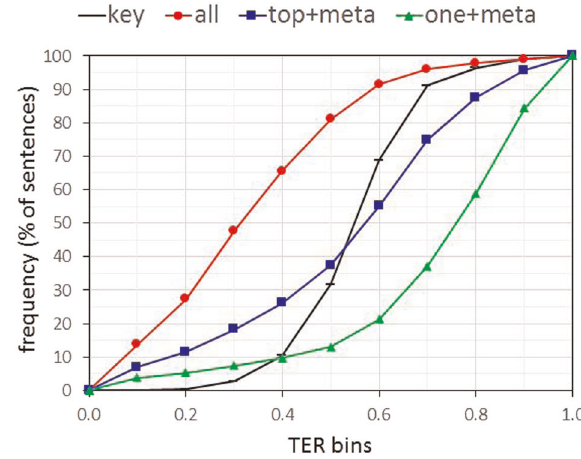
Fig. 3 Cumulative distributions (CDFs) of the TER bins for the key , all , top + meta , and one + meta sentences for test-gen-mhr . X -axis plots TER bins. Y -axis — respective cumulative frequencies of the test- gen-mhr